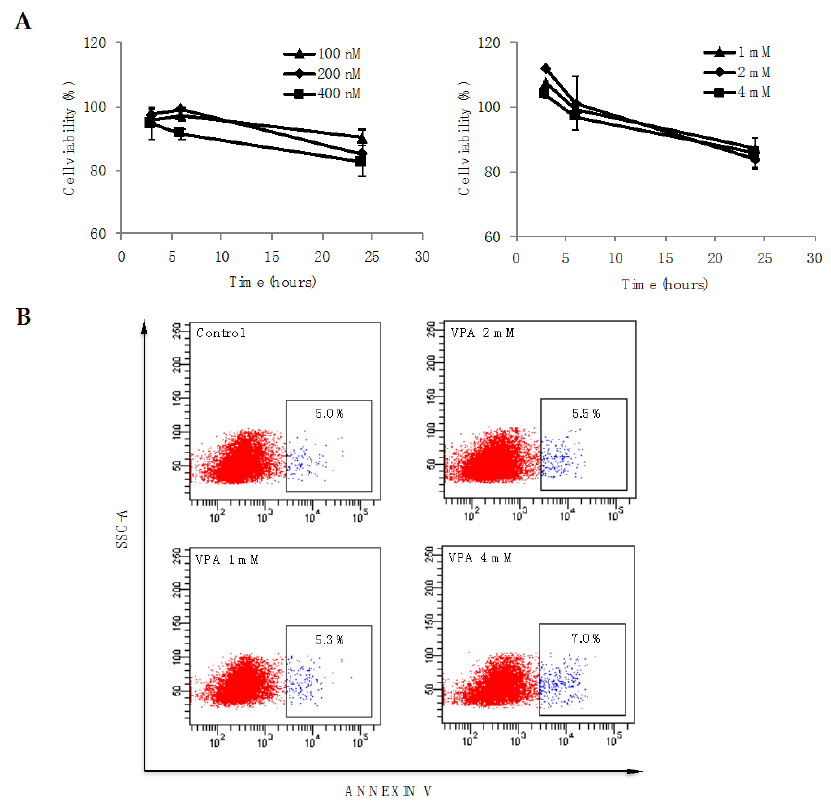
Figure 2. Cell viability of PBMCs pre-treated with TSA and VPA. ( A ) PBMCs were treated with different concentrations of TSA (left panel) or VPA (right panel) and their metabolic activity was quantified after 3, 6 and 24 h using resazurin. The percentage viability was calculated as described in the methods section. Error bars represent the mean ± SEM of three independent experiments; ( B ) PBMCs were treated with different concentrations of VPA, and after 24 h, CD14+ cells were analyzed for apoptosis using Annexin